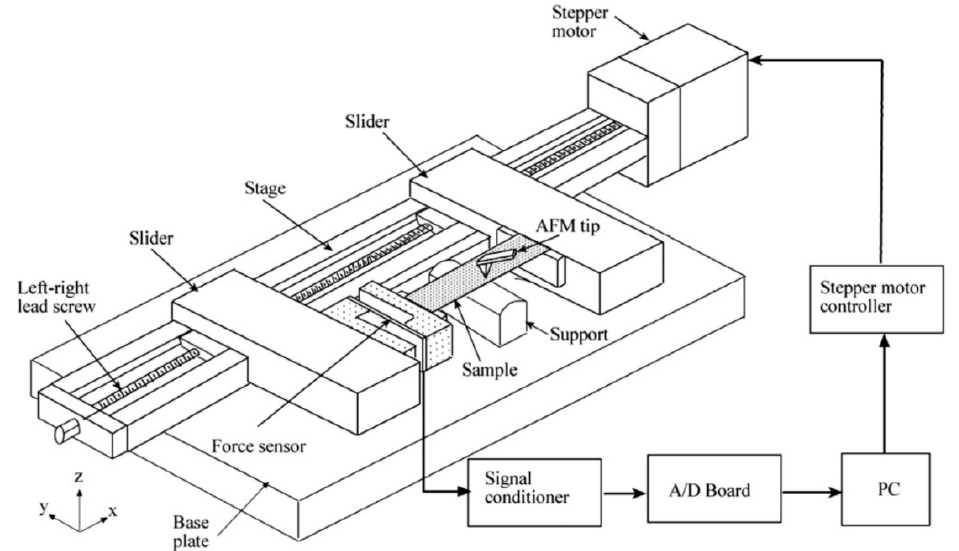
Figure 6. Custom-built setup for testing tribological properties of skin at a nano level [55]. Repro- duced with permission from Bhushan, B., Nanotribological and nanomechanical properties of skin with and without cream treatment using atomic force microscopy and nanoindentation; published by Elsevier,